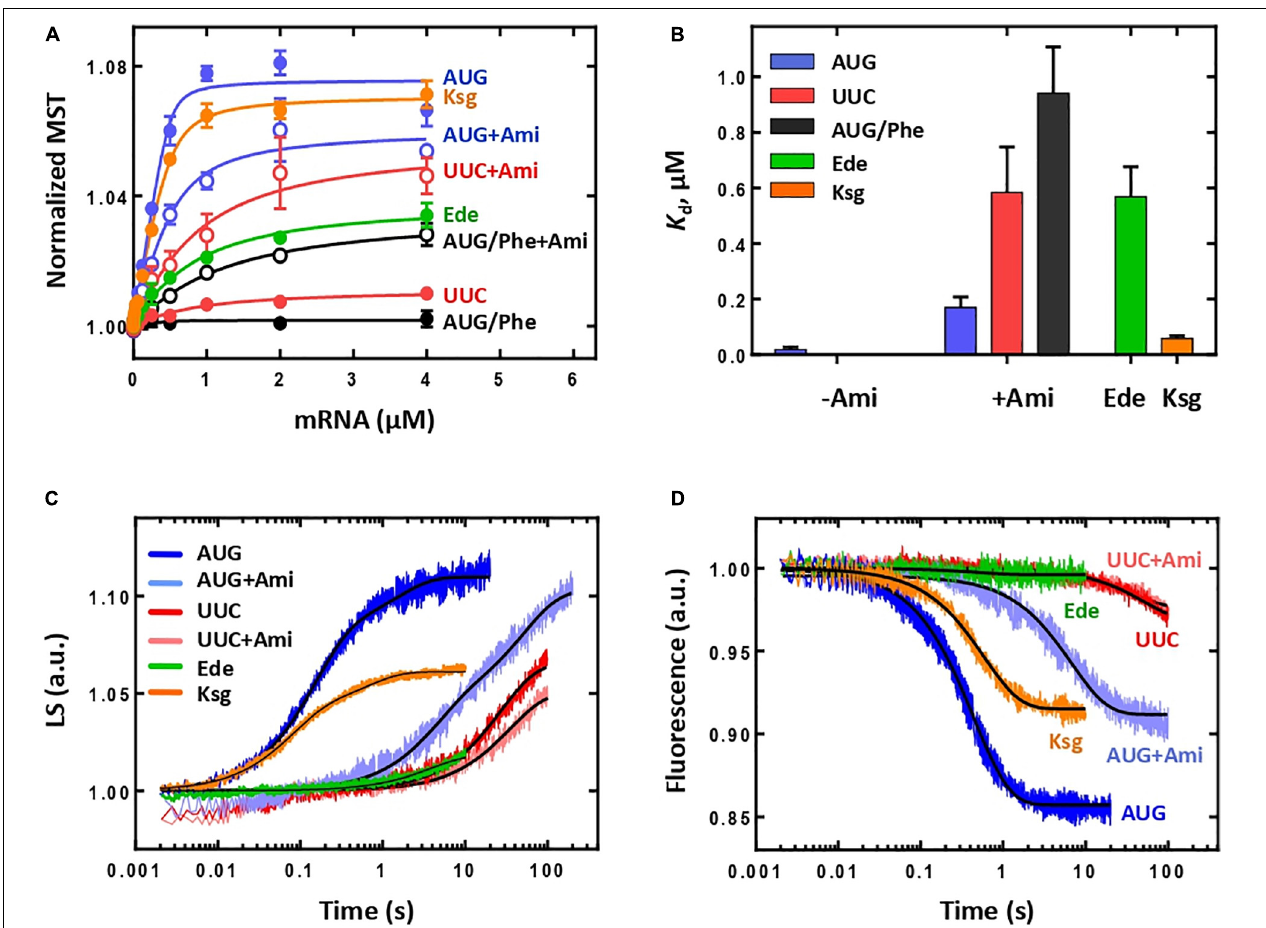
FIGURE 2 | The influence of Ami on the initiation in a complete system. (A) Titration of the 30S IC formation with mRNA containing AUG start codon (denoted as AUG, in the presence of Ami, AUG + Ami; Ede, edeine; Ksg, kasugamycin), UUC start codon (denoted as UUC, in the presence of Ami – UUC + Ami), AUG start codon with the participation of the elongator BPY-Phe-tRNA Phe (denoted as AUG/Phe, in the presence of Ami – AUG/Phe + Ami). (B) Dissociation constants ( K d ) calculated from (A) . The K d value for mRNA with AUG in the absence of Ami is very low and practically not visible on the graph; the K d values for mRNA with UUC start codon or AUG codon with the participation of Phe-tRNA Phe in the absence of Ami are not shown as they do not form the initiation complex. (C) Association of the 50S subunit (0.3 µ M) with the 30S IC (0.1 µ M) monitored by light scattering. Time curves are labelled according to the mRNA start codon and presence of Ami, Ede, or Ksg. (D) Association of the 50S subunit (0.3 µ M) with the 30S IC (0.1 µ M) monitored by fluorescent signal from the BPY reporter of the initiator BPY-Met-tRNA fMet , labelling as in (C)